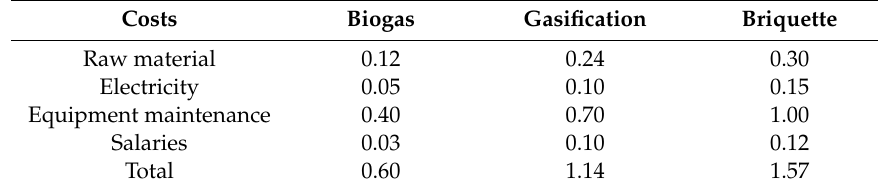
Table 2. Variable costs of the three project modes (unit: million CNY per